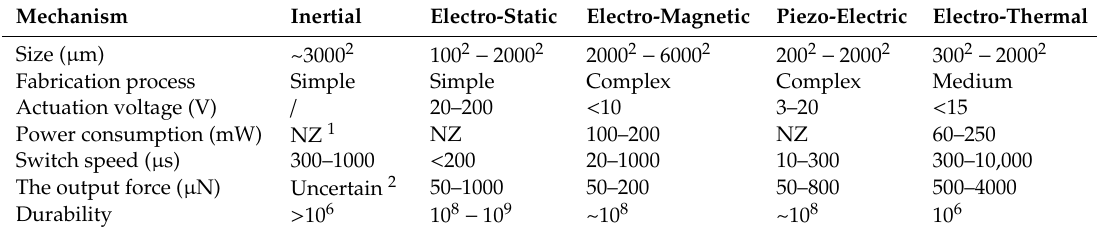
Table 2. Performance comparison of MEMS switches with di ff erent driven